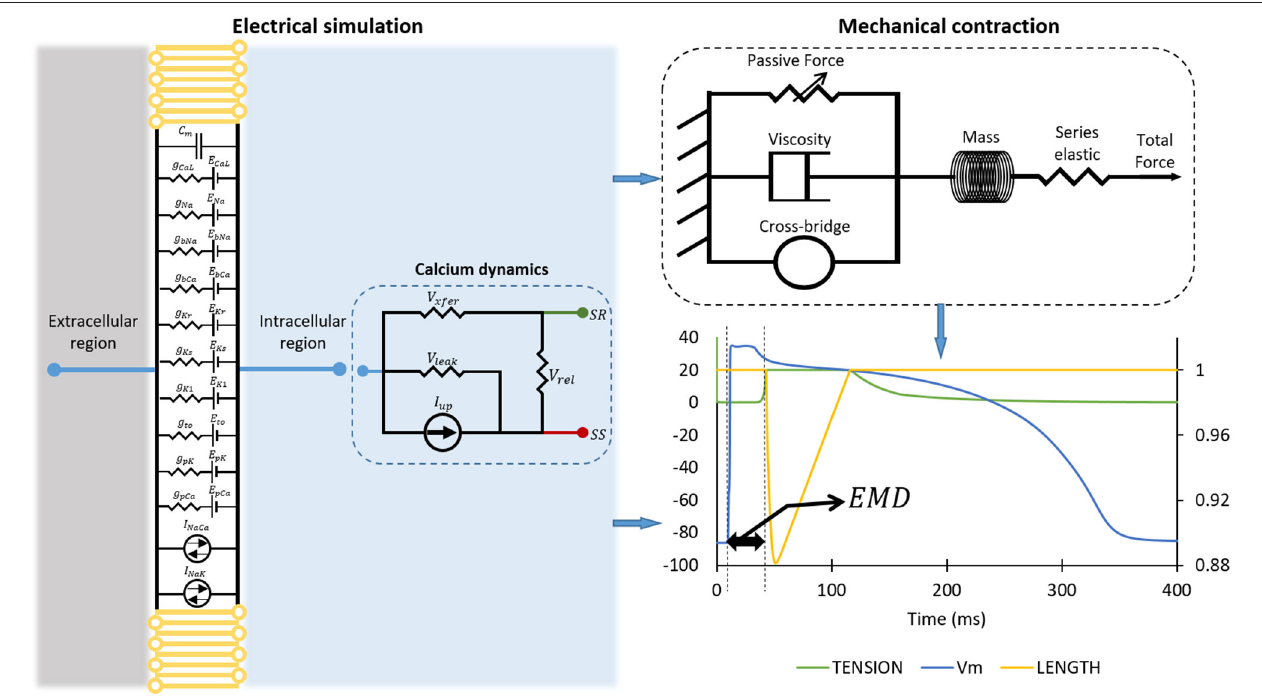
FIGURE 1 | The simulation protocol for obtaining two EMDs. The diagram on the left panel shows the mode of myocardial tissue. The mechanical contraction of the cell is depicted on the top right of the figure, while the bottom right of the figure shows how we calculated EMD from the electrical action potential and mechanical contraction. Please note that the plot on the bottom right has the primary x -axis as time in milliseconds, the y -axis as membrane potential of the cell in millivolt, and the secondary y -axis (on the right) as the normalized length of the